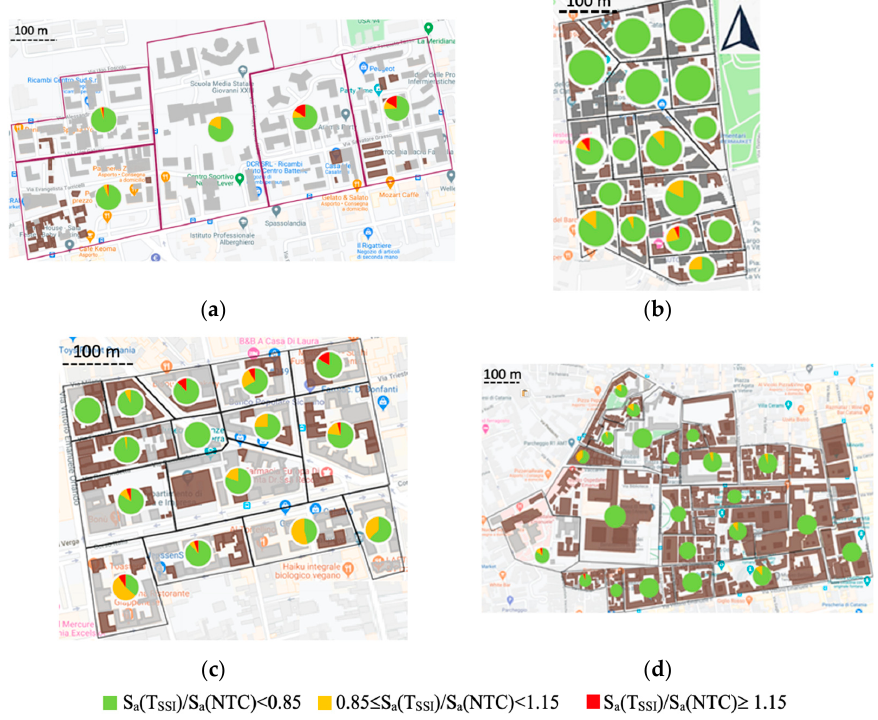
Figure 22. Spatial distribution of S a (T SSI )/S a (NTC2018) ratios for the 2002 seismic input: ( a ) west area; ( b ) northeast area; ( c ) north Old Town; ( d ) south Old Town.